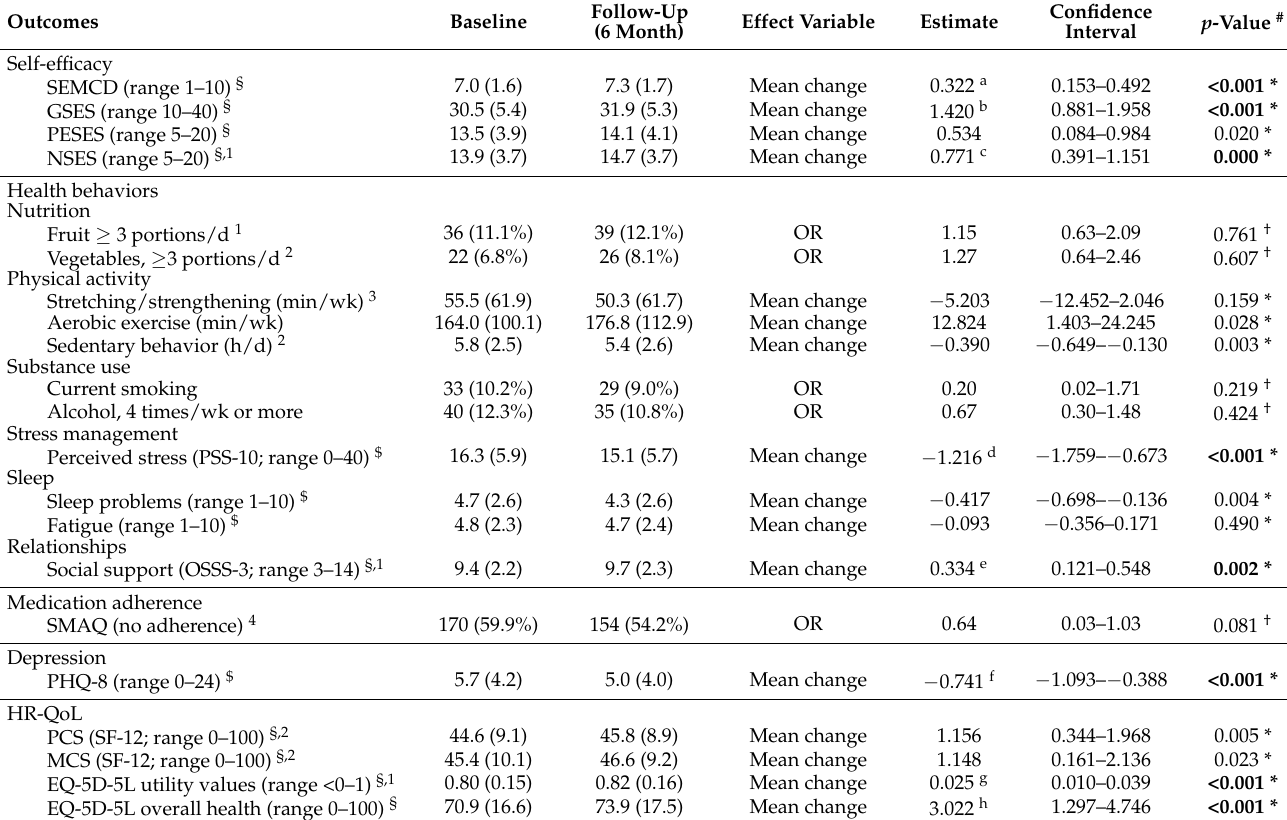
Table 2. Effects of SEFAC mindfulness-based intervention ( n =